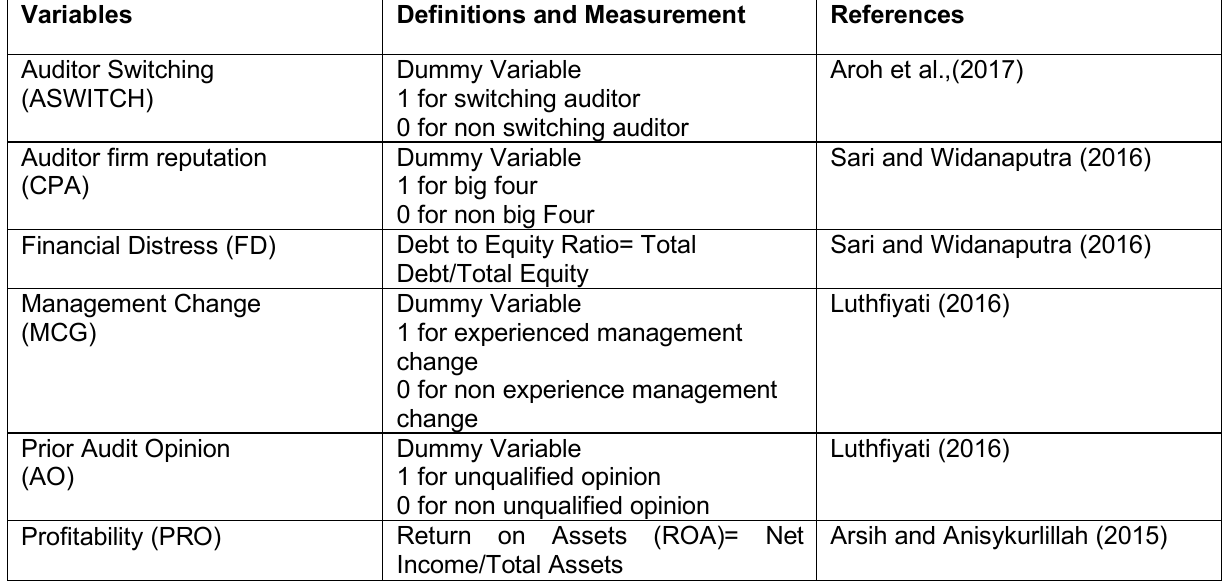
Table 1: Variables, Definitions and